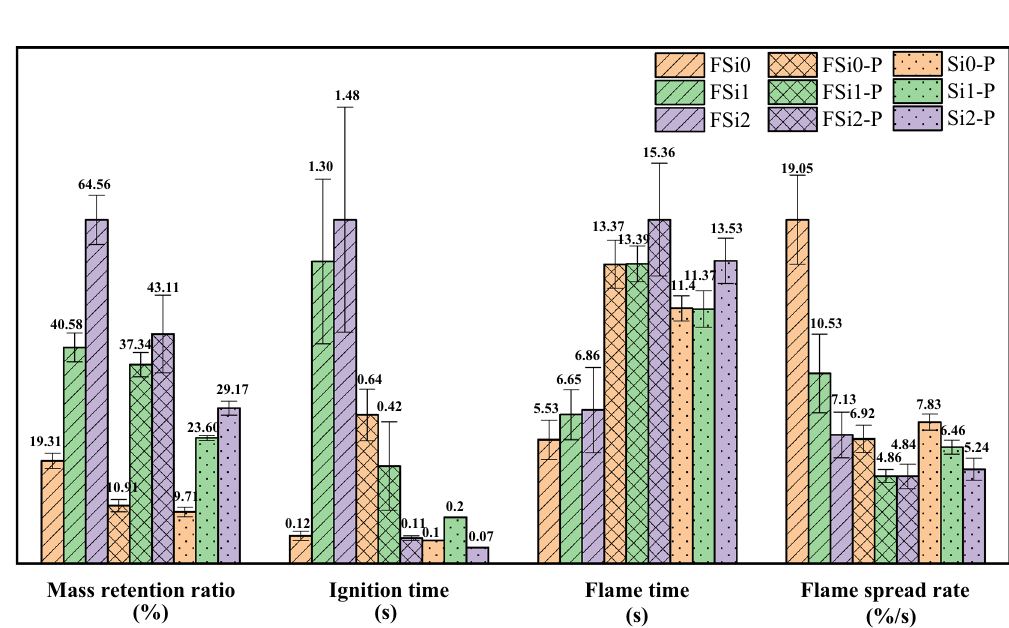
Figure 13. Upward flame spread test results for fungal fibers grown with Si